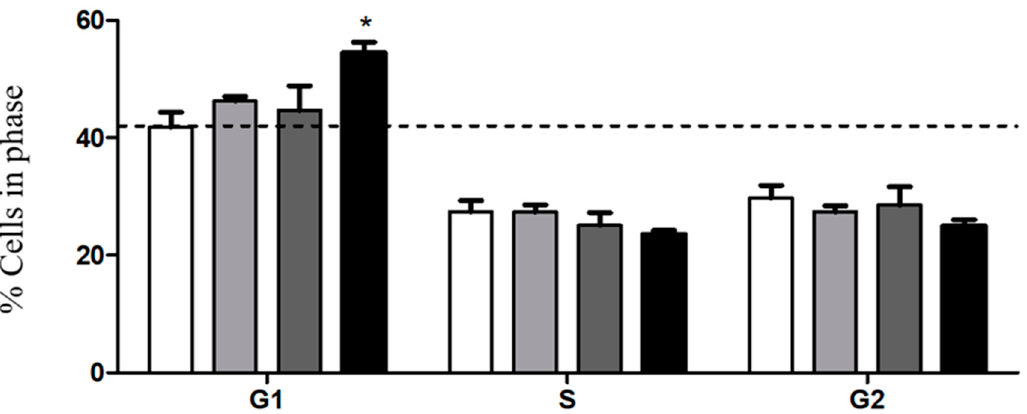
Figure 14. – Effect of NPs on tumour cell cycle progression. Cellular DNA was stained with propidium iodide (PI) to determine cell cycle distribution. Percentage of cells in G1, S and G2 cell cycle phases in no addition (control; white), Free PvD (light grey), PvD-loaded BSA NPs (dark grey) and ERL conjugated PvD-loaded BSA NPs (black), after 24 h incubation. Results are expressed as mean ± SEM for three different experiments. * p < 0.05 from control by one-way ANOVA test.